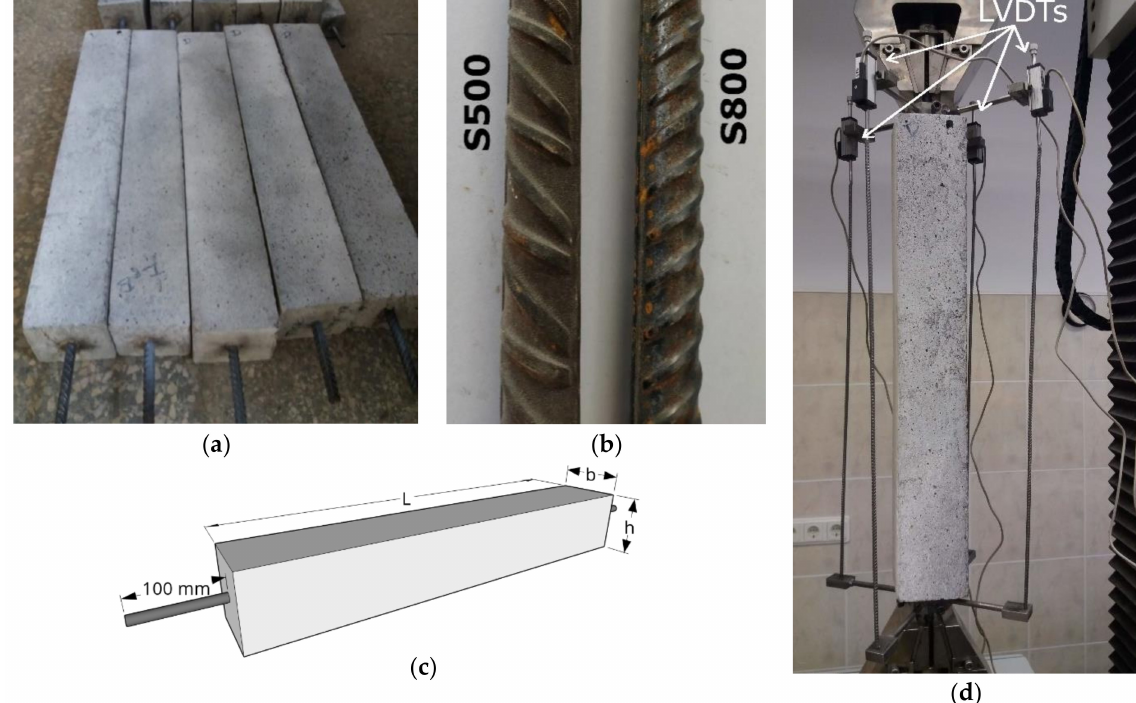
Figure 2. Photographs of the experimental test displaying the RC ties ( a ) and the rib pattern difference between S500 and S800 rebars ( b ). ( c ) An illustration of the RC ties to clarify their dimensional characteristics. ( d ) The RC tie clamping and testing by means of a universal testing machine (UTM). Table 1 details the concrete prism dimensions of the members (in combination